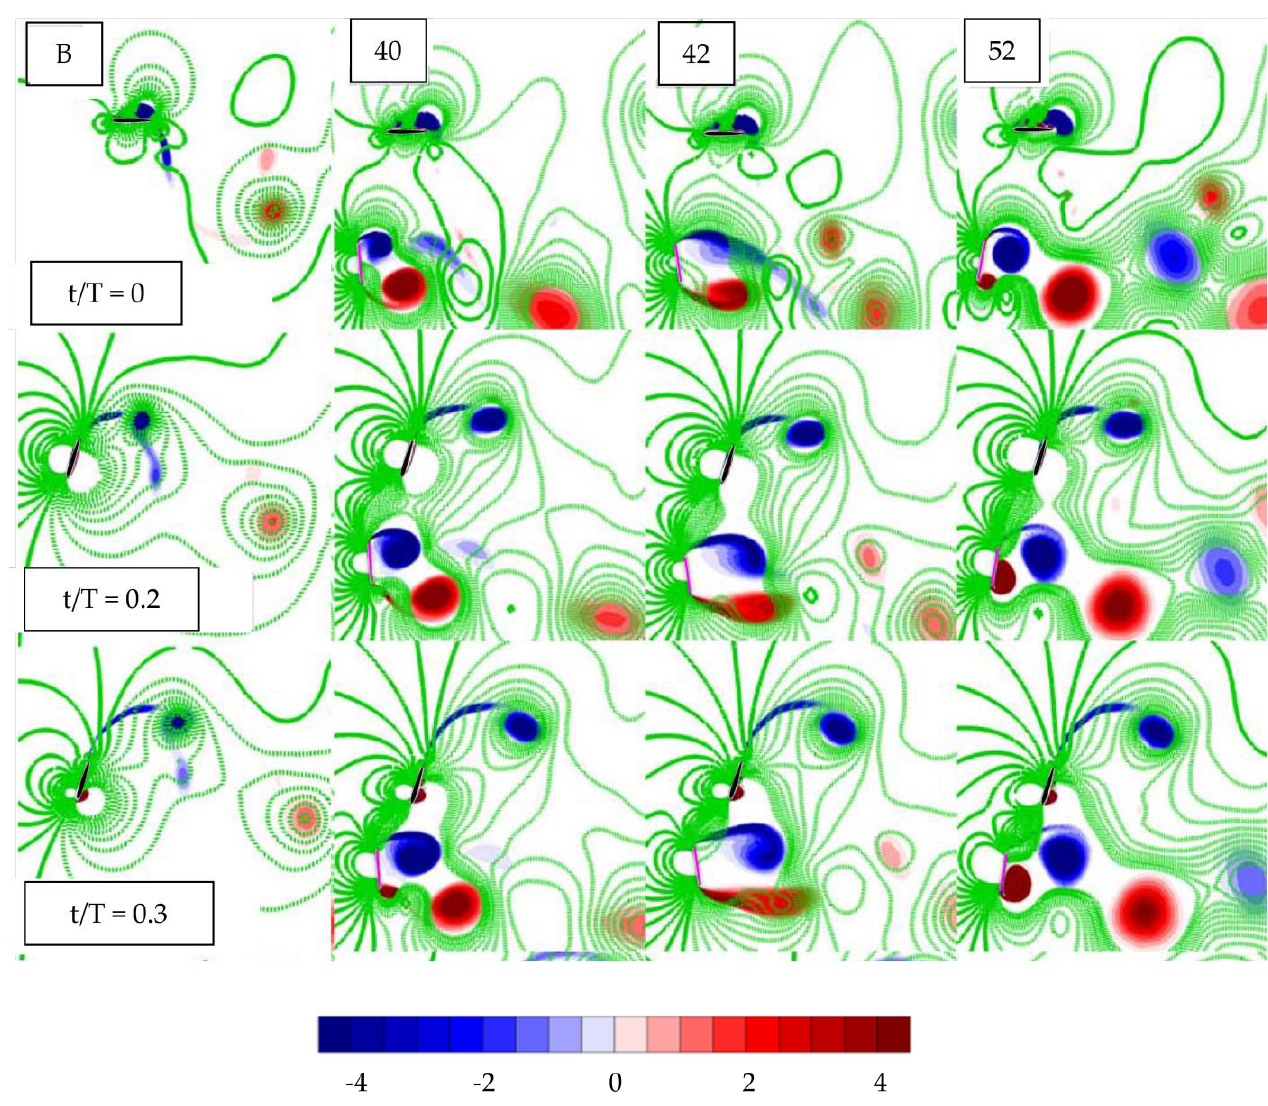
Figure 19. A comparison of the vortex structures and isolines of pressure of an oscillating hydrofoil for different tilt angles of the upstream deflector during downstroke (solid isolines: positive pressure; dashed isolines: negative pressure).